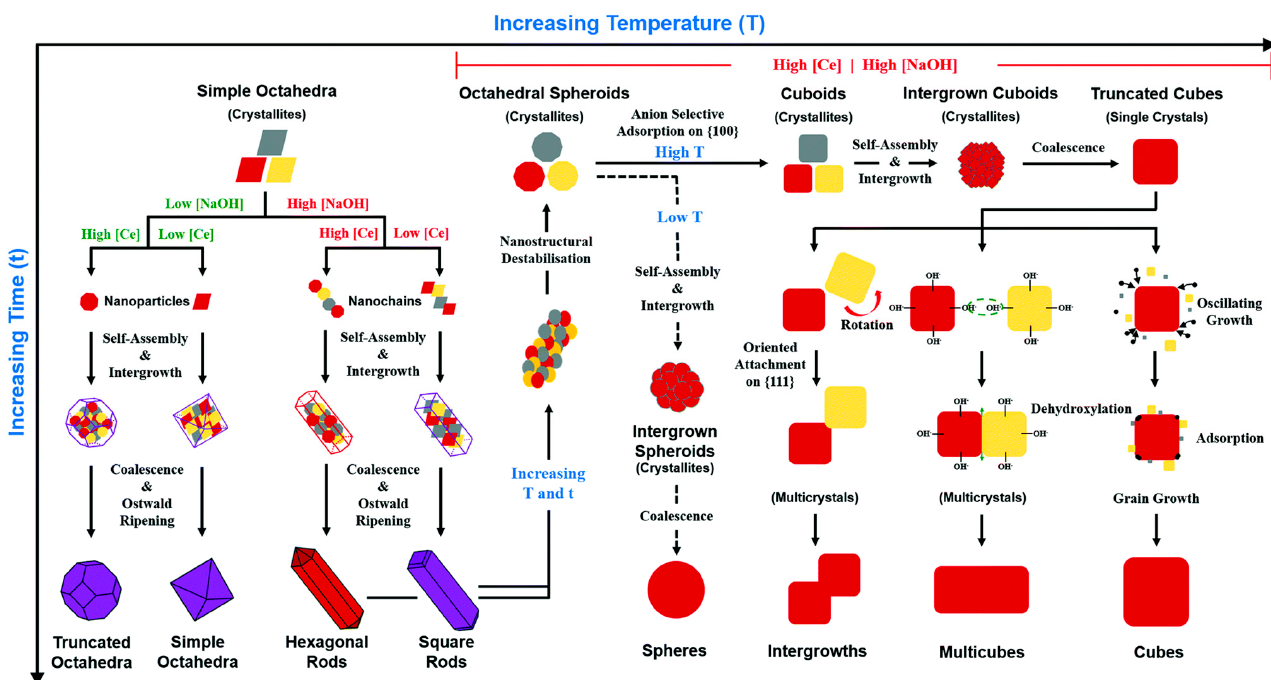
Figure 21. Schematic of solution growth mechanisms of CeO 2 − x nanomorphologies (red/yellow = investigated by Xu et al. [194]; purple = from the literature; [Ce]: low < 0.50 M ≤ high; [NaOH]: low < 5.00 M ≤ high; T : low < 150 °C ≤ high; t : short ≤ 2 h < long) [194]. Reproduced from Xu, Y.; Mofarah, S.S.; Mehmood, R.; Cazorla, C.; Koshy, P.; Sorrell, C.C. Design strategies for ceria nanomaterials: untangling key mechanistic concepts. Mater. Horiz. 2021 , 8 , 102–123—Published by The Royal Society of Chemistry.